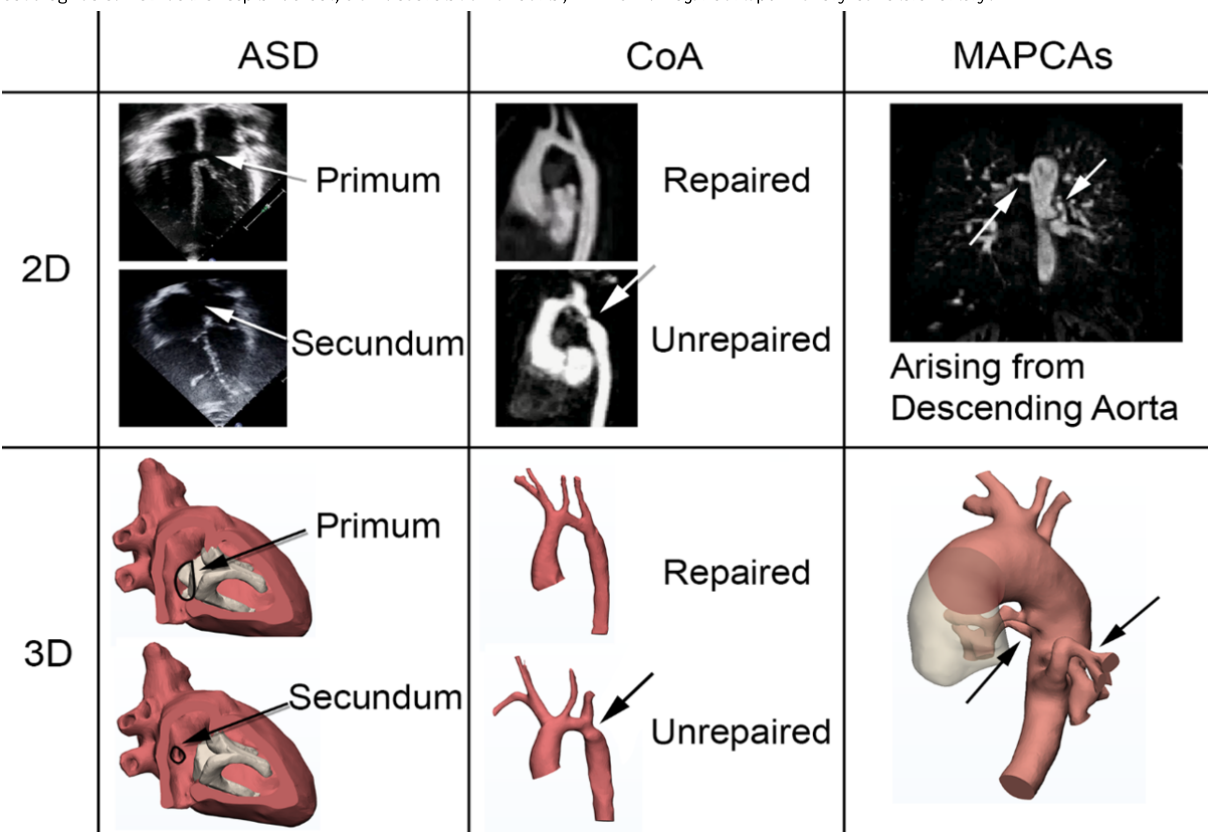
Figure 1. Medical images of the congenital heart disease cases: 2D (top) and 3D (bottom). Arrows represent the anatomical regions to scrutinize for